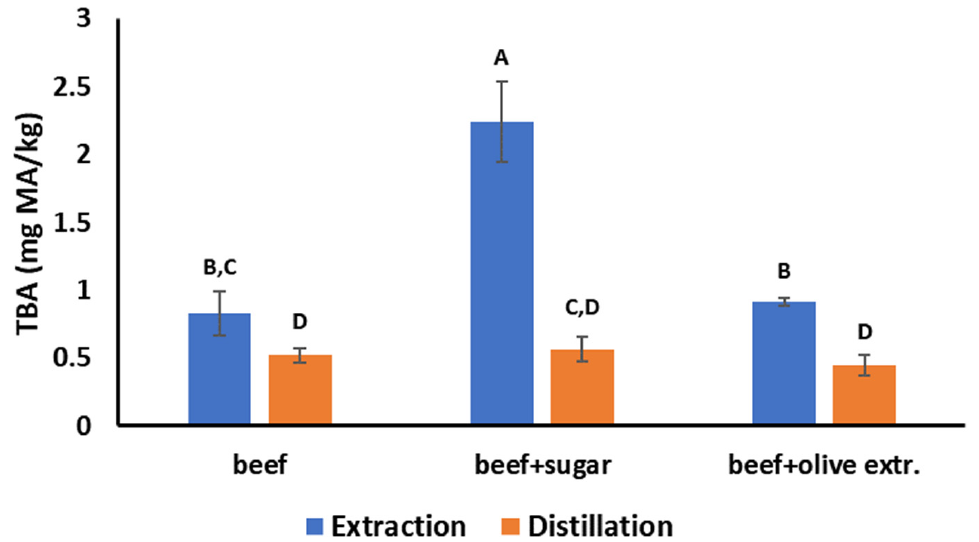
Figure 3. Comparison of the steam distillation and the modified extraction TBA method in plain ground beef, in ground beef with 2% added sugar, and in ground beef with 2% added olive extract. Different letters indicate statistically significant differences ( p < 0.05) among the six treatments.